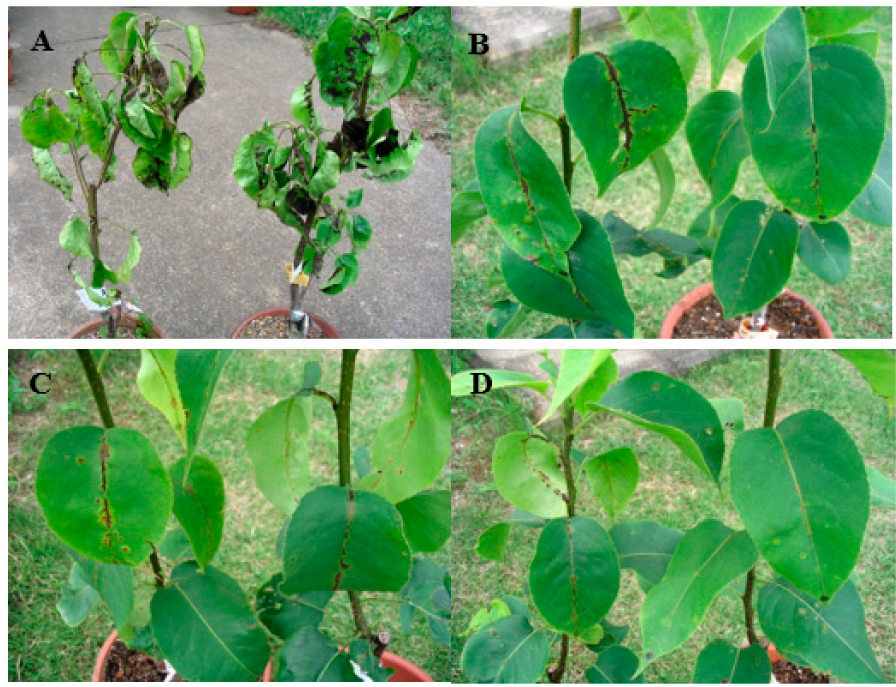
Figure 1. Control efficacy of fenarimol (on the right of each photo) sprayed preventatively and curatively at 30 mg/L AI against scab disease on potted Japanese pear trees (cultivar: Kousui). Distilled water was sprayed as a reference (on the left of each photo). Trees were inoculated with the conidial suspensions prepared from ( A ) naturally occurring sporulating lesions collected from Ukiha 2, ( B ) the single-spore isolate Kurokawa 21 produced in culture, ( C ) the single-spore isolate Kurokawa 22 produced in culture, and ( D ) naturally occurring sporulating lesions collected from the NIAES. Photos were taken one month after